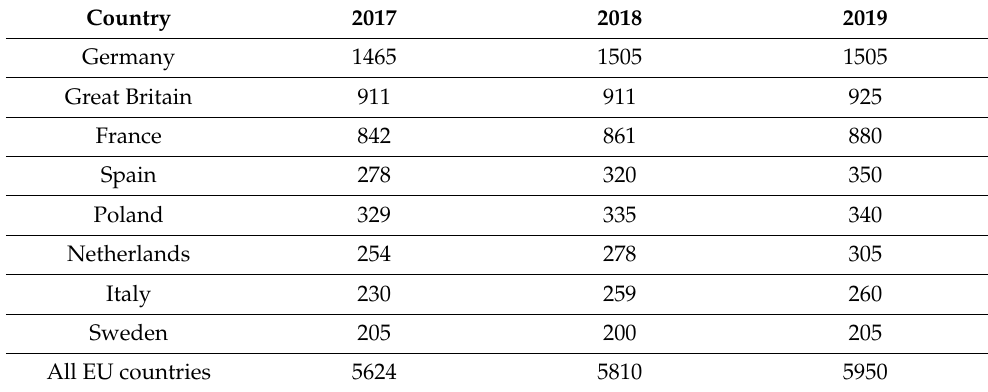
Table 1. Bioethanol market capacity in EU countries in 2017–2019, million liters [17].